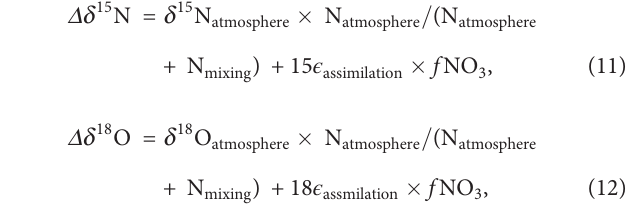
( Figure 5E ). Neither phytoplankton assimilation nor mixing South China Sea is enough to lead to d 18 O − NO − 3 values